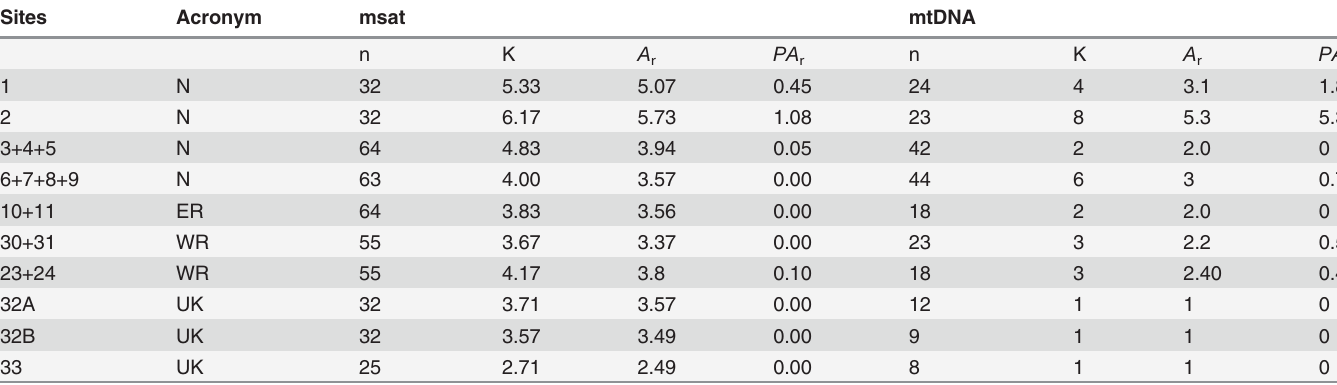
Table 2. Genetic diversity for Dikerogammarus villosus calculated for microsatellites (msat) or mitochondrial DNA (mtDNA) within sampling sites or groups of sites. Sites